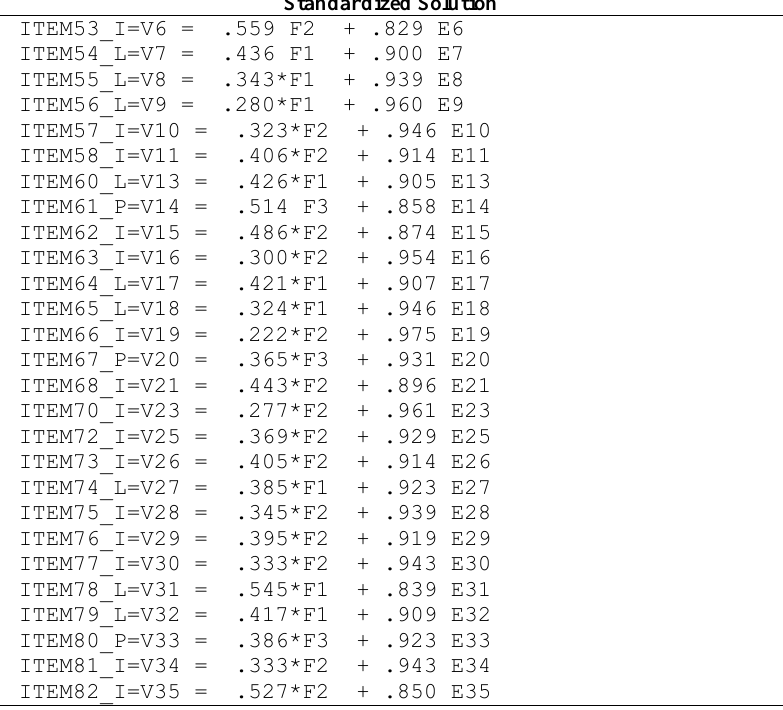
Parameter Estimates for the 3-trait Modified Model of Reading Ability Standardized Solution ITEM53_I=V6